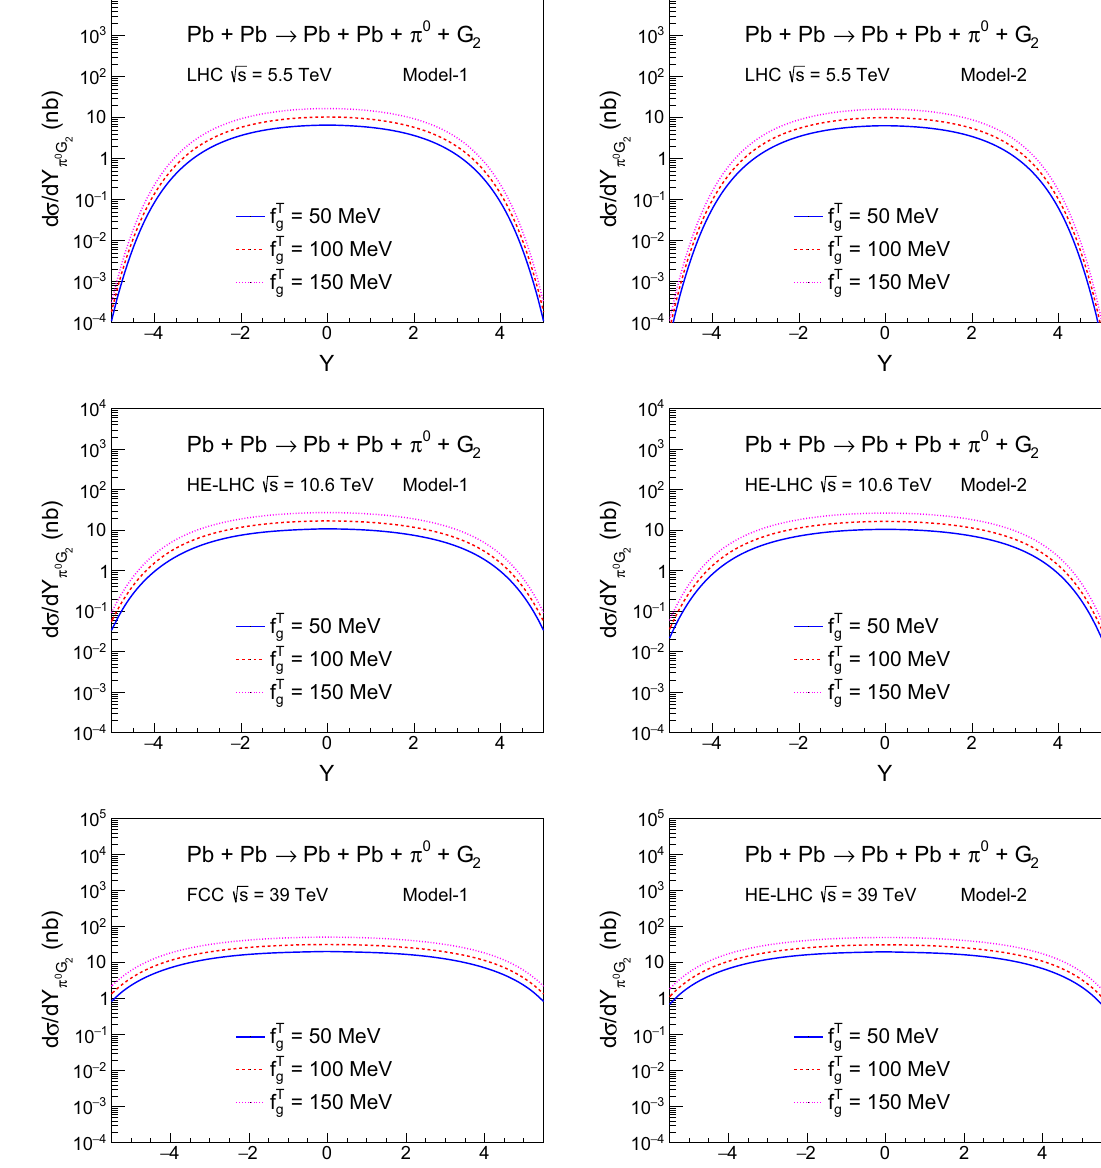
Fig. 5 Rapidity distributions for the UPC process Pb + Pb → Pb + Pb + G 2 + π 0 with model-1 (left panels) and model-2 (right panels). From top to bottom, it represents the predictions for the LHC,